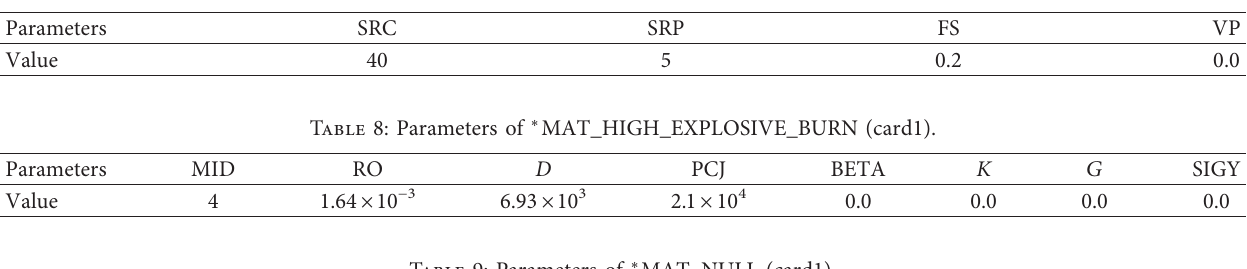
Table 7: Parameters of ∗ MAT_PLASTIC_KINEMATIC (card2).